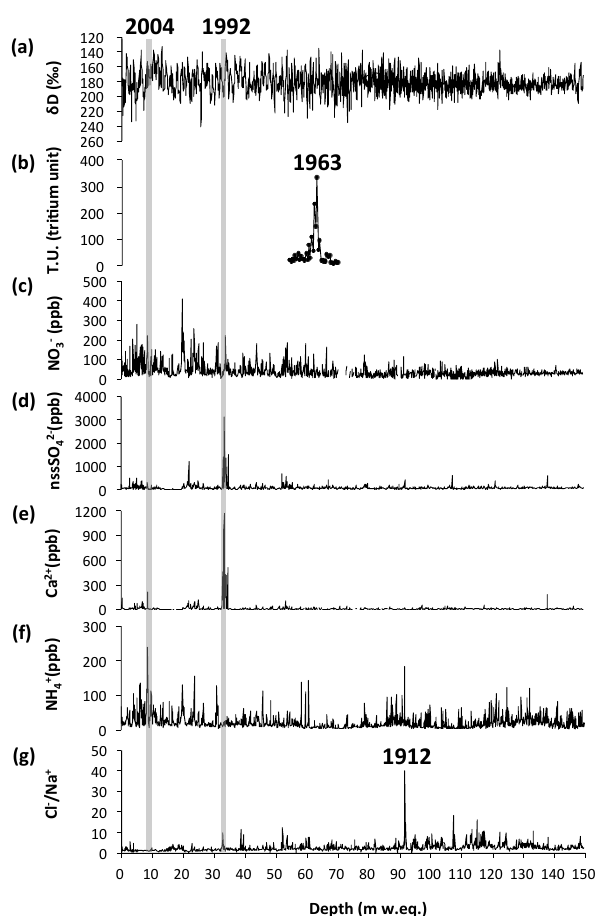
Figure 3. (a) Stable hydrogen isotopes ( δ D), (b) tritium unit, (c) NO − , (d) non-sea-salt sulfate (nssSO 2 − 3 and (g) Cl − /Na + plotted against water equivalent depth. The gray shading indicates dirty layers.